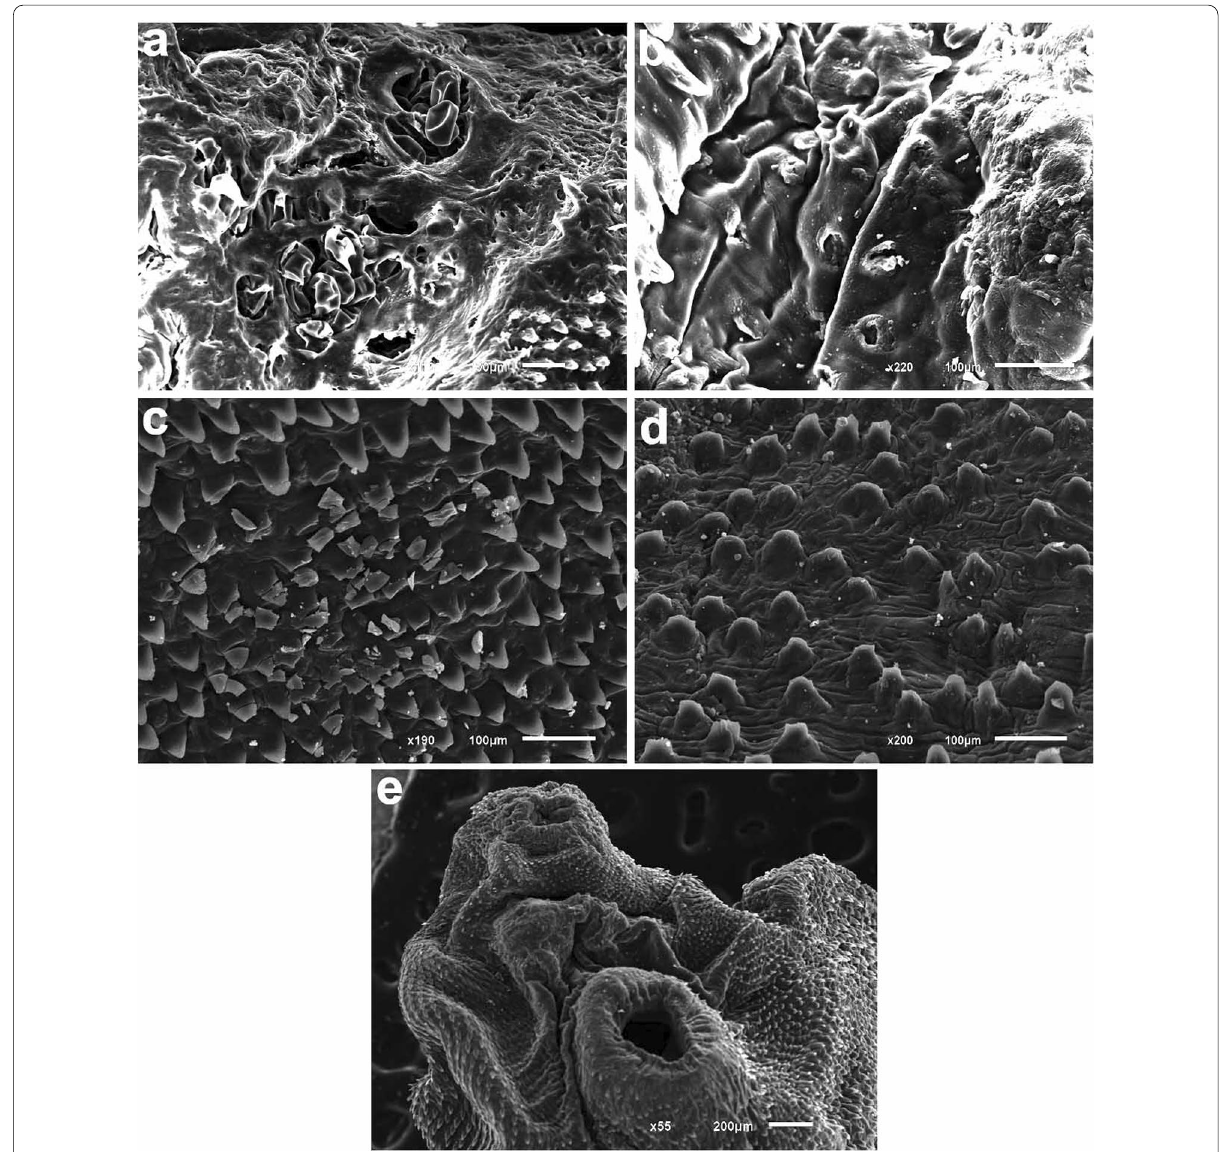
Fig. 4 SEM of triclabendazole‑treated Fasciola gigantica adult worm. a Tegumental surface showing swelling and mild furrowing. b Moderate damaged spine dorsally. c Mild damaged spines on ventrally. d Thickness of the cuticle ranged from 258 to 270. µm. e Ventral sucker 243–250